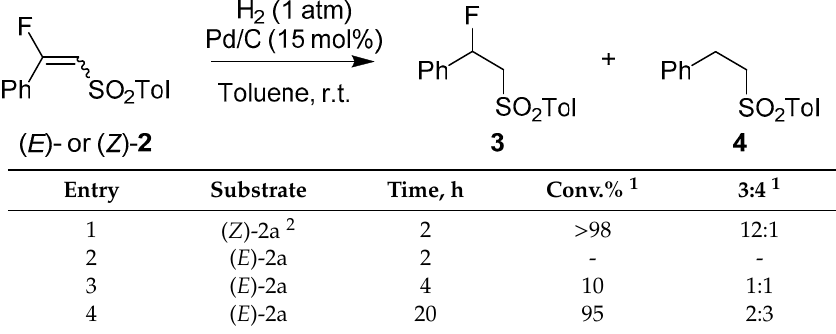
Table 2. A comparison of the hydrogenation of both ( E )- and ( Z )-fluorovinyl